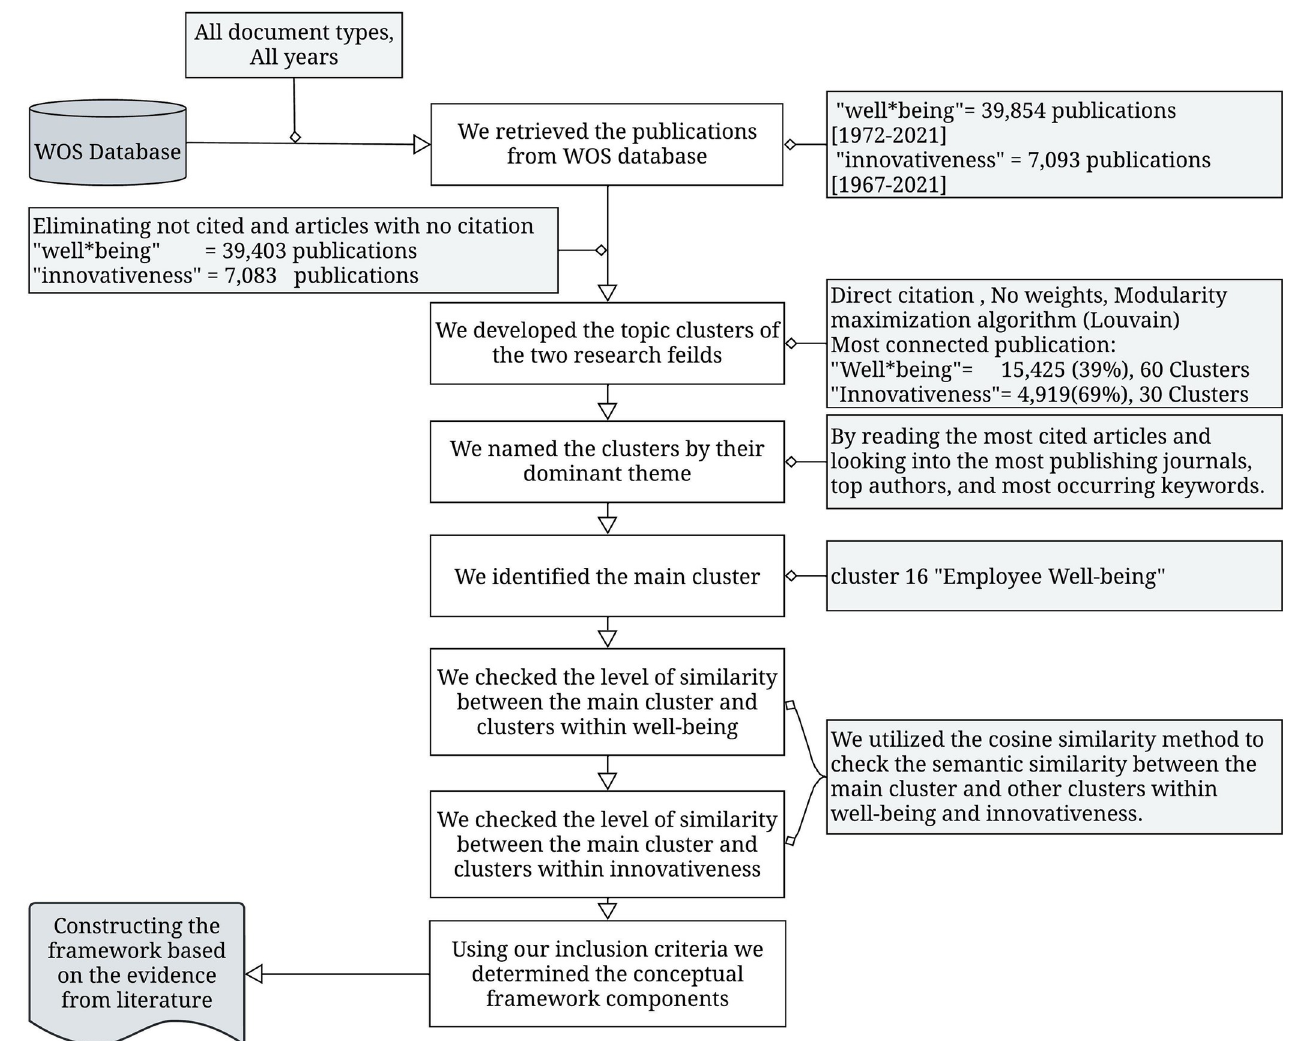
Fig 1. Flow chart summarizing the steps and methods we utilized to build our conceptual